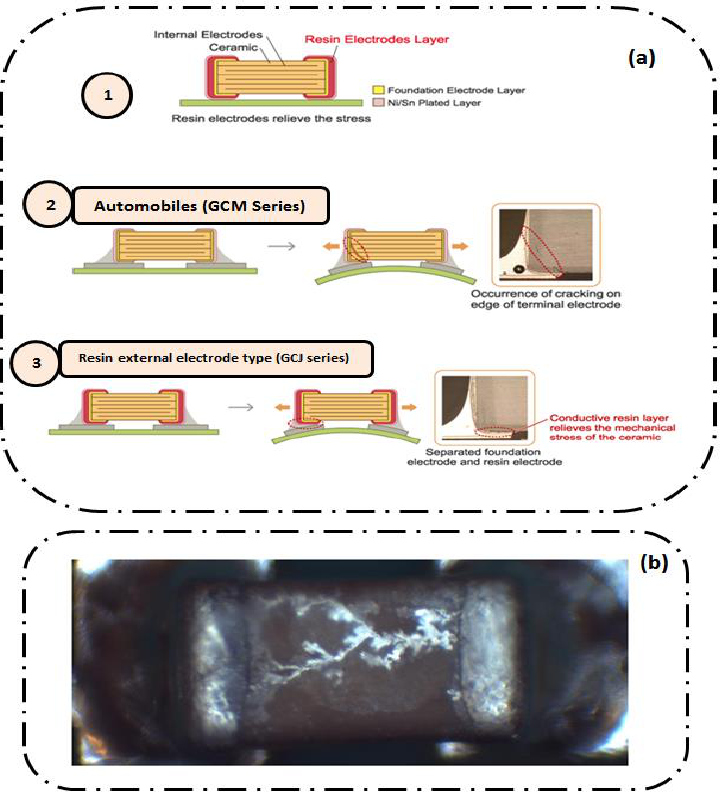
Figure 9. ( a ) MLCC schematic illustrating resin electrodes; ( b ) Dendritic growth on MLCC